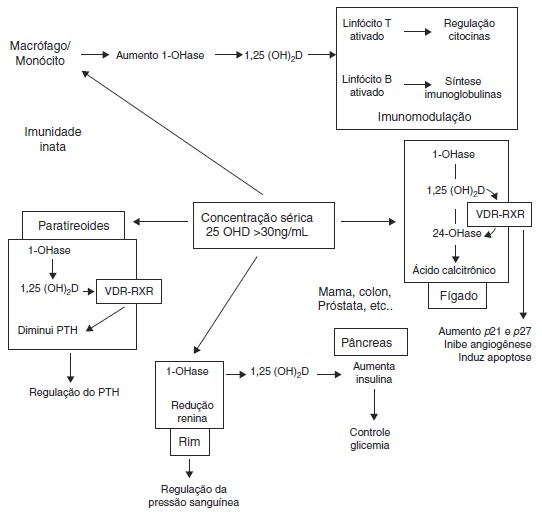
Funções não esqueléticas da 1,25-dihidroxivitamina D. Adaptado de Holick
MF et al.8 VDR, receptor da vitamina D; RXR, região alvo; 1-OHase,
25-hidroxivitamina D-1a-hidroxilase; 25(OH)D, 25-hidroxivitamina D;
1,25(OH)2D, 1,25-di-hidroxivitamina D; 24-OHase, 25-hidroxivitamina
D-24-hidroxilase; p21 e p27, genes envolvidos no controle da proliferação,
inibição da angiogênese e apoptose celulares.